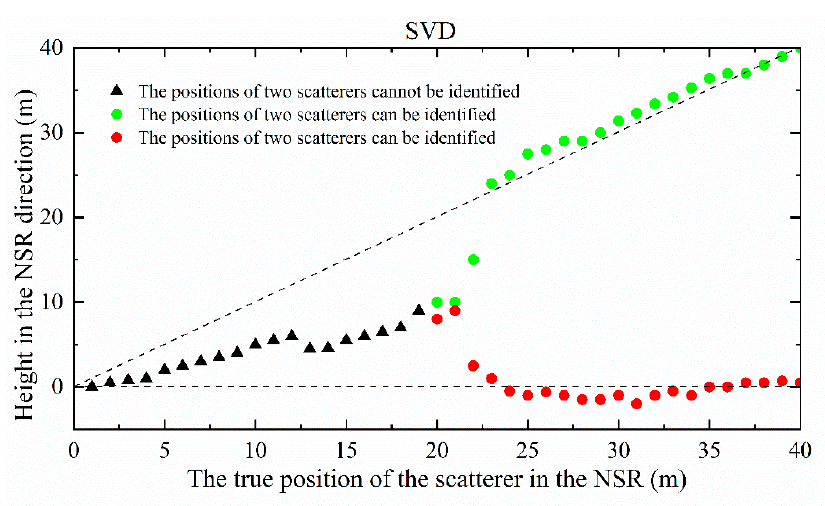
Figure 7. Simulation results of NSR resolution for SVD.